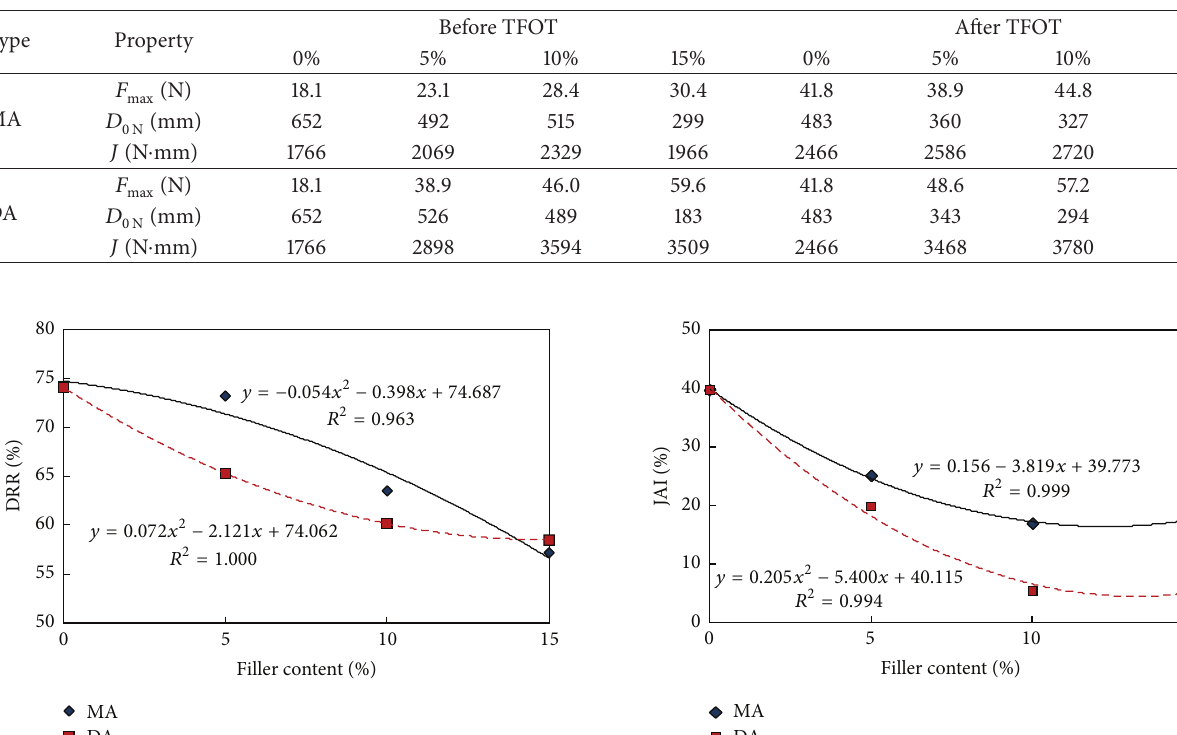
Table 5: Results of force ductility test.